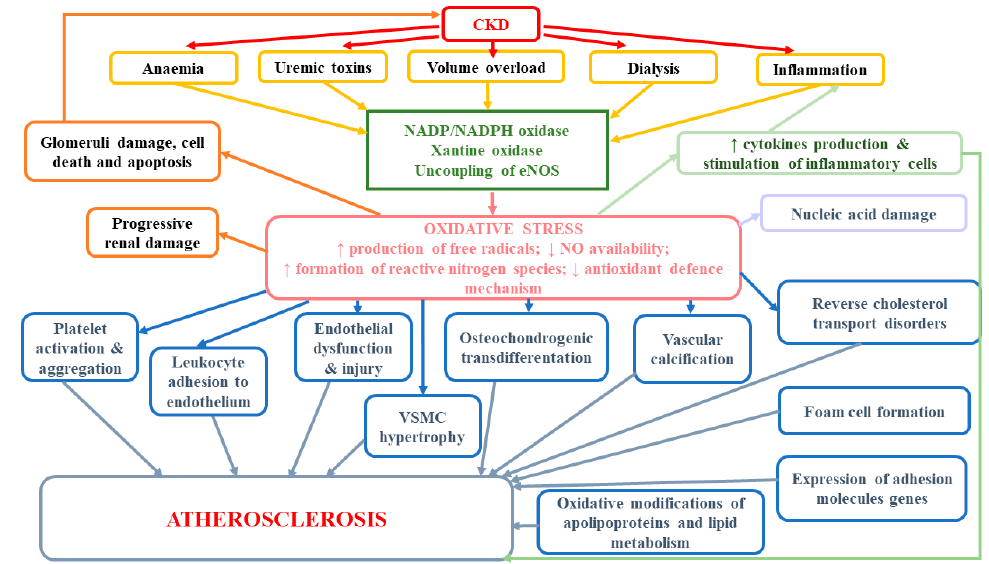
Figure Figure 2. The role of oxidative stress in the development of atherosclerosis and other adverse consequences.